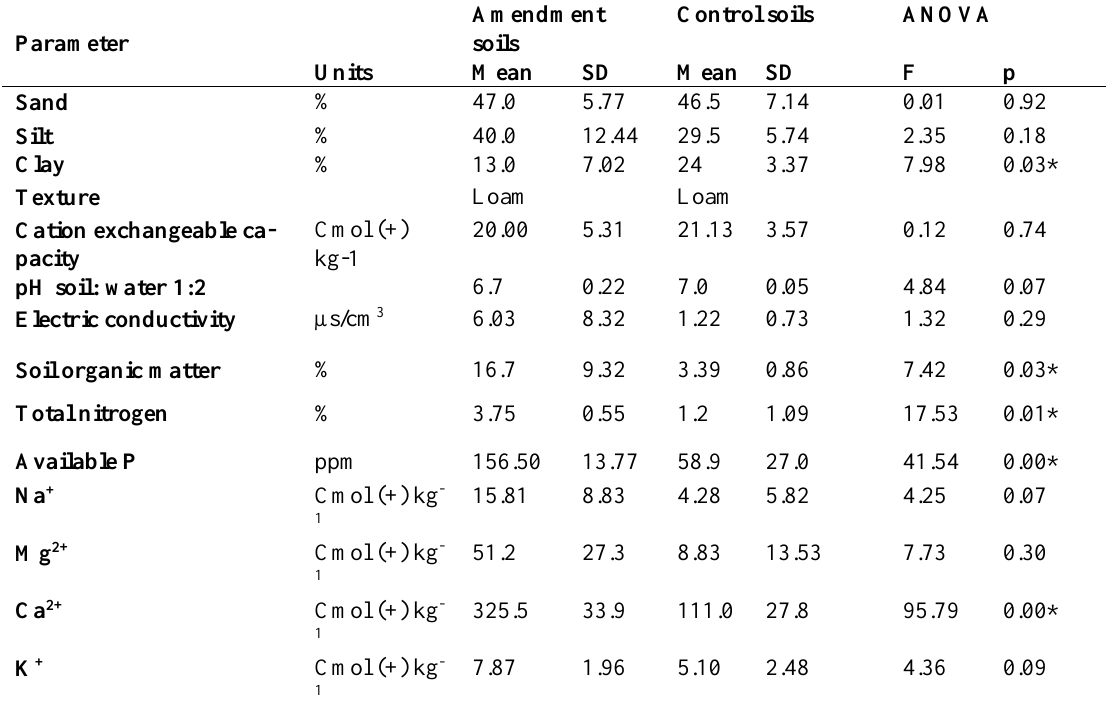
Table 2 Physicochemical properties of post-harvest soils with sewage sludge amendment and control soils after harvesting * p<0.05